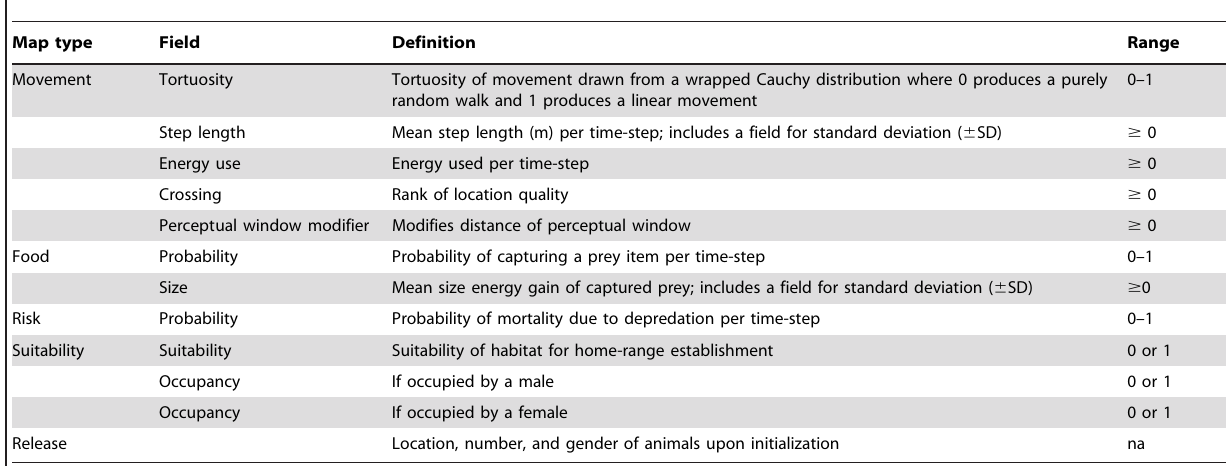
Table 1. Landscape parameter maps and field definitions input by the user to reflect variation in animal behavioral or physiological responses to different GIS